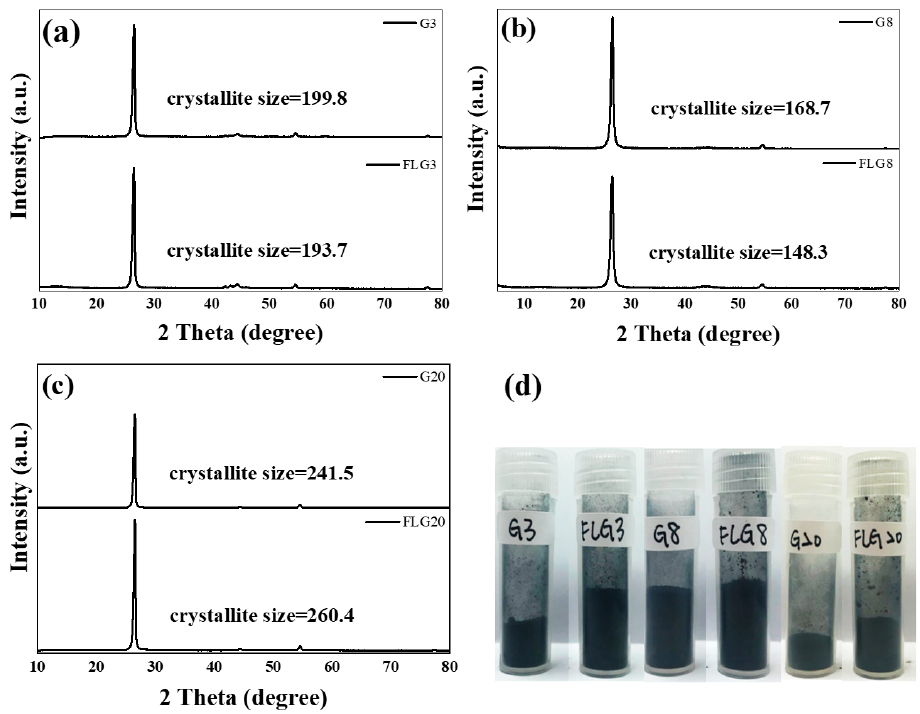
Figure 3. XRD patterns of ( a ) G3 and FLG3, ( b ) G8 and FLG8, and ( c ) G20 and FLG20, and a ( d ) comparison of those of powder before and after manufacturing by a low-temperature ultra-high pressure continuous homemade flow cell disrupter